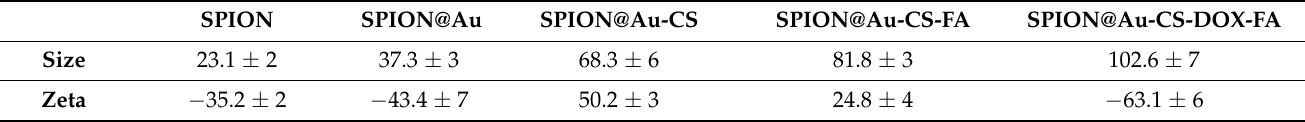
Table 2. Hydrodynamic scale and zeta potential parameters of the synthesized NPs.